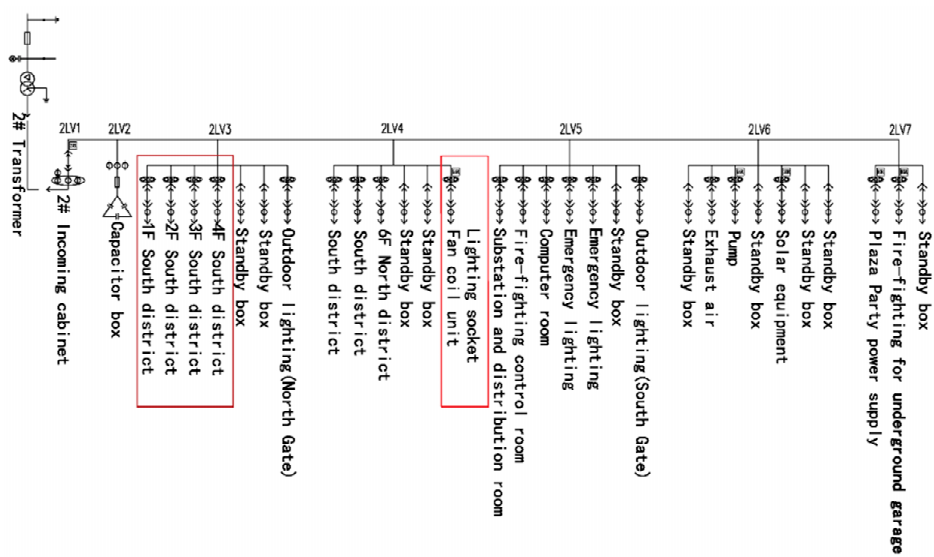
Figure 2. Construction drawing of electric energy monitoring for a sample building studied in this paper.